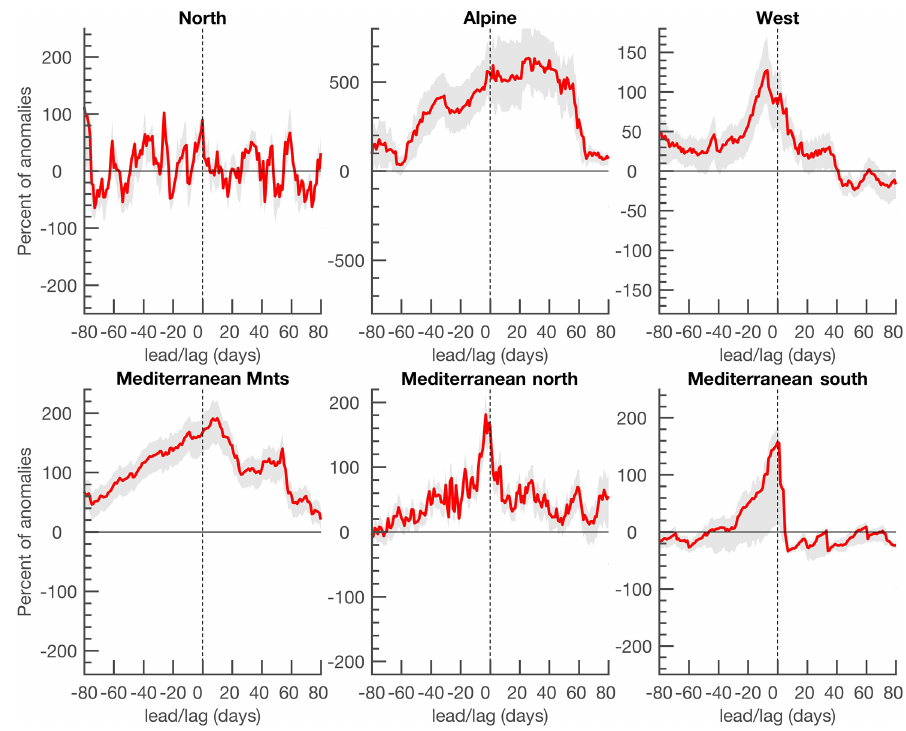
Figure 8. Same as Fig. 7 but for specific regions. Note the different ranges on the y axis. Mnts is